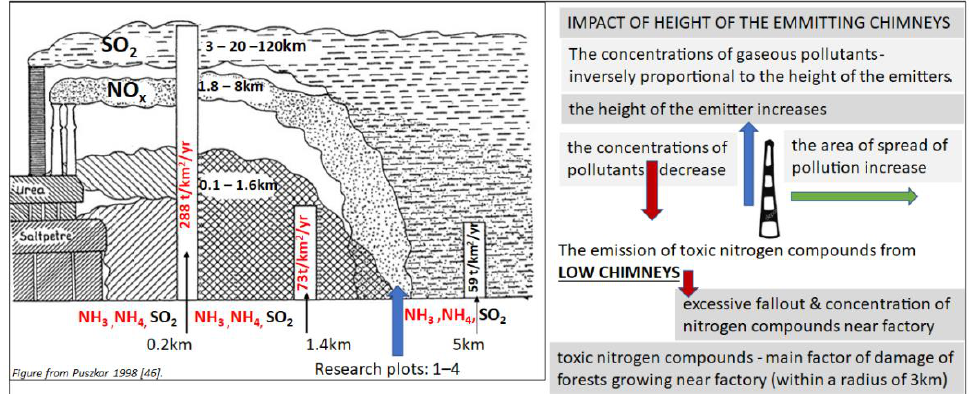
Figure 10. Extent and amount of air pollution emitted by Zakłady Azotowe Puławy.